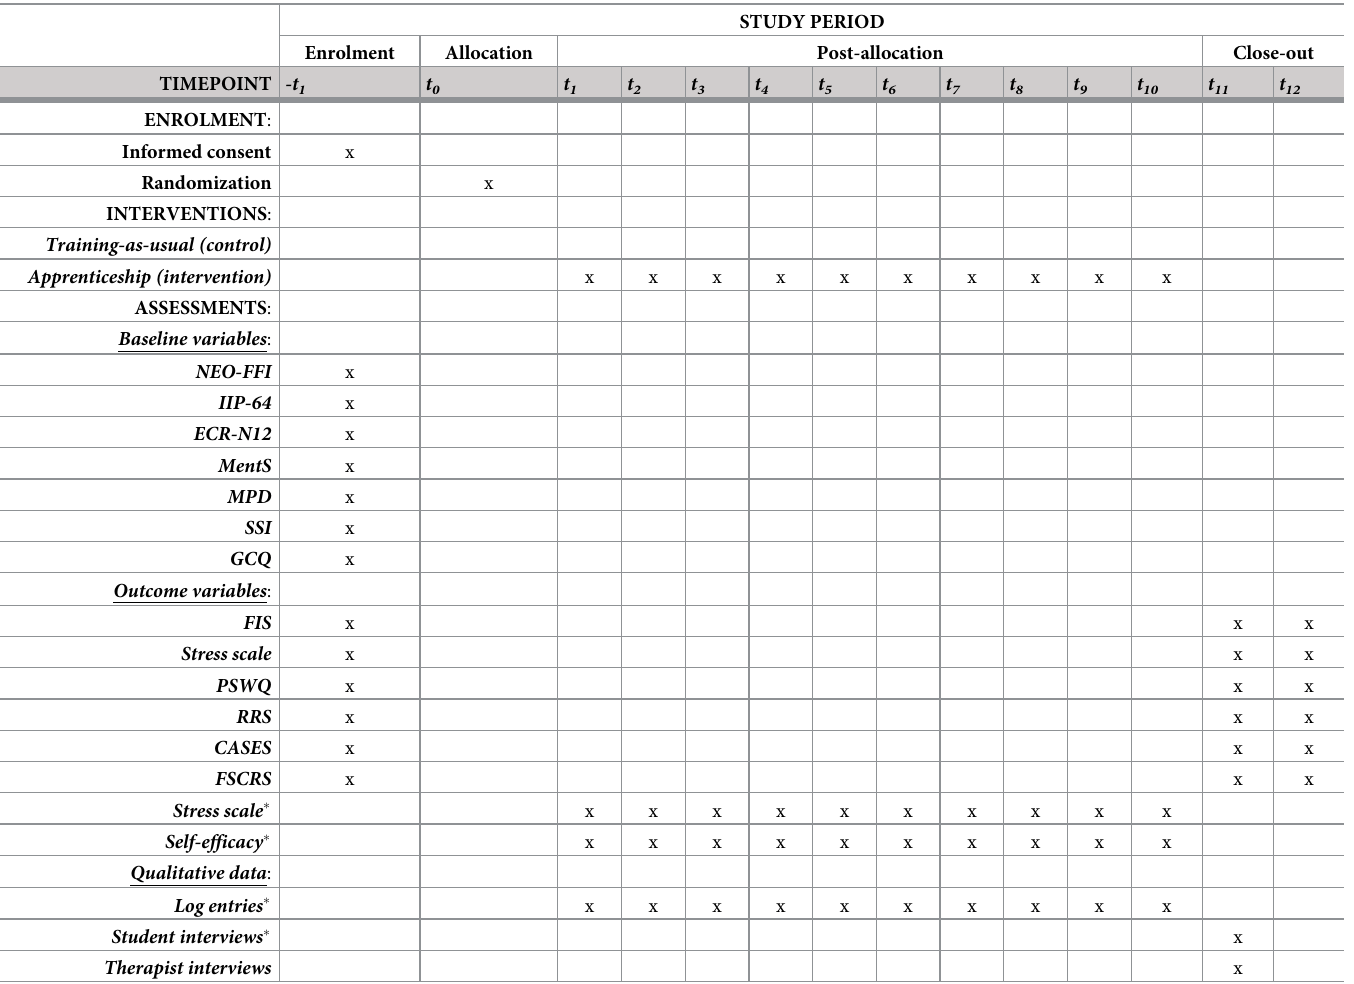
Table 1. Schedule of enrolment, interventions, and